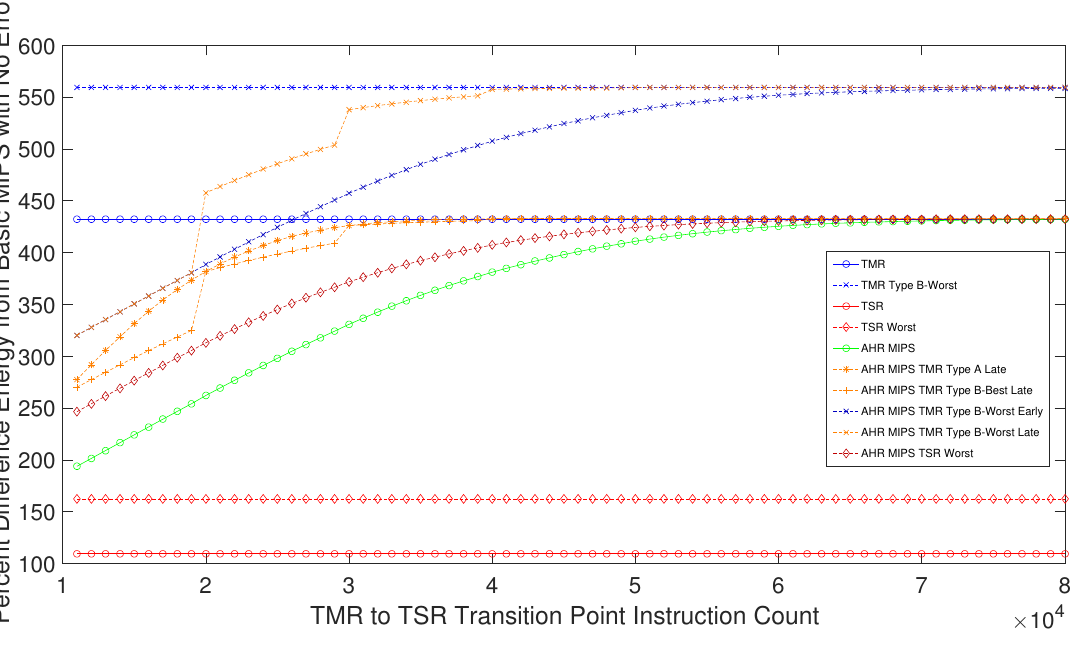
Figure 18. AHR MIPS TMR to TSR transition varying from 11,000 to 80,000 instructions: energy vs. time to